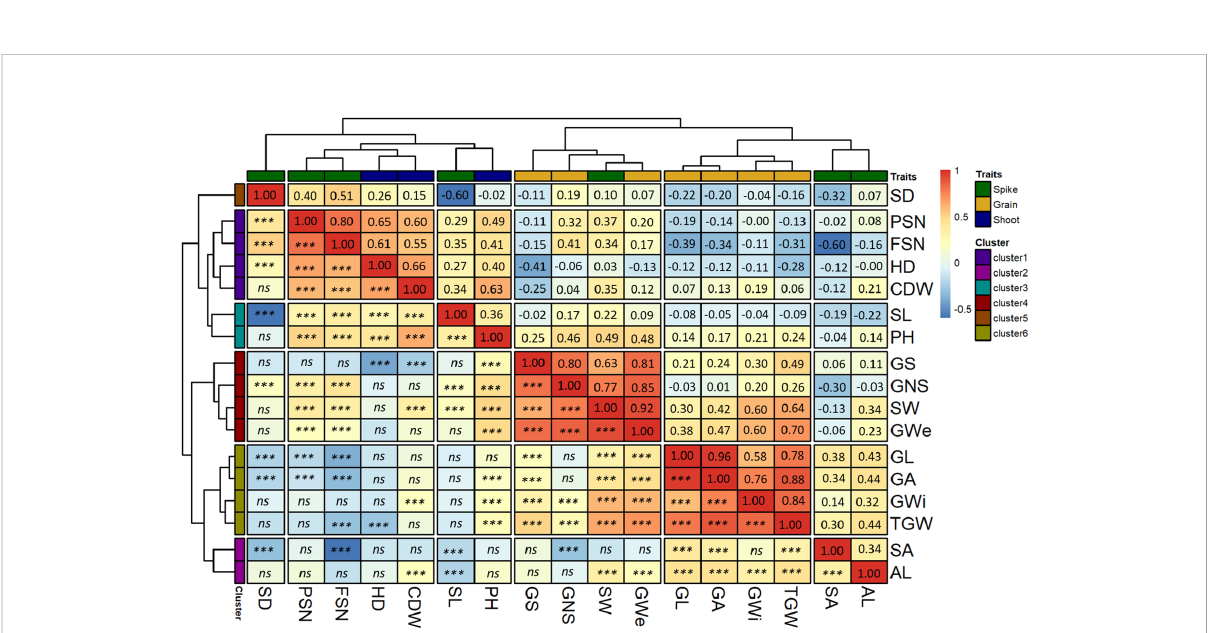
FIGURE 4 Hierarchical clustering based on the Pearson-product moment correlation analysis among the BLUEs of the investigated traits. The x- and y- axis both represent the investigated traits. The spike, grain and shoot traits are color-coded as shown in the legend “ Traits ” . The second legend shows the scale for Pearson-product moment correlation. The spike traits highlighted by the green color includes potential spikelet number (PSN), fi nal spikelet number (FSN), spikelet abortion (SA in %), spike length (SL in cm), spike weight (SW in g), spike density (SD) and awn length (AL). Grain traits highlighted by the yellow color includes grain number per spike (GNS), grain length (GL in mm), grain width (GWi in mm), grain area (GA in mm 2 ), grain weight per spike (GWe in g), grain set (GS in %), thousand-grain weight (TGW in g) and the shoot traits represented by blue color includes in heading date (HD in days from January 1 st ), plant height (PH in cm) and culm dry weight (CDW in g). *** = signi fi cant association at 0.001 probability level and ns represents non-signi fi cant association.